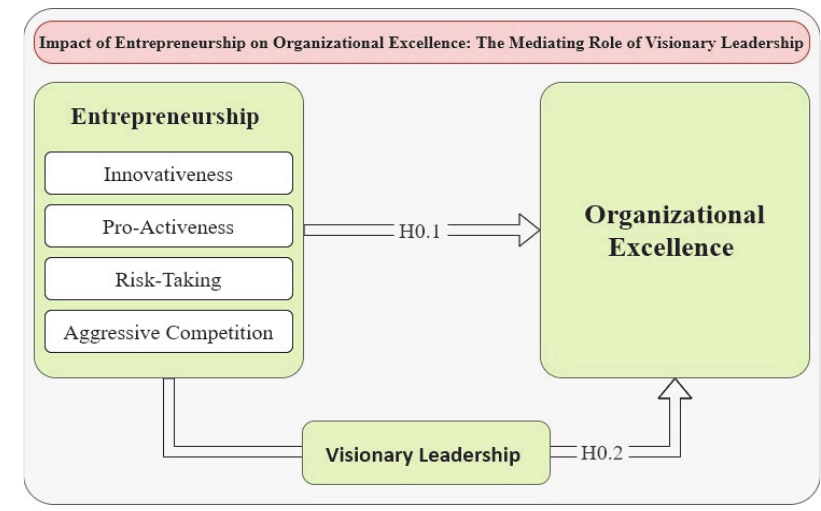
Fig. 1. Research proposed model